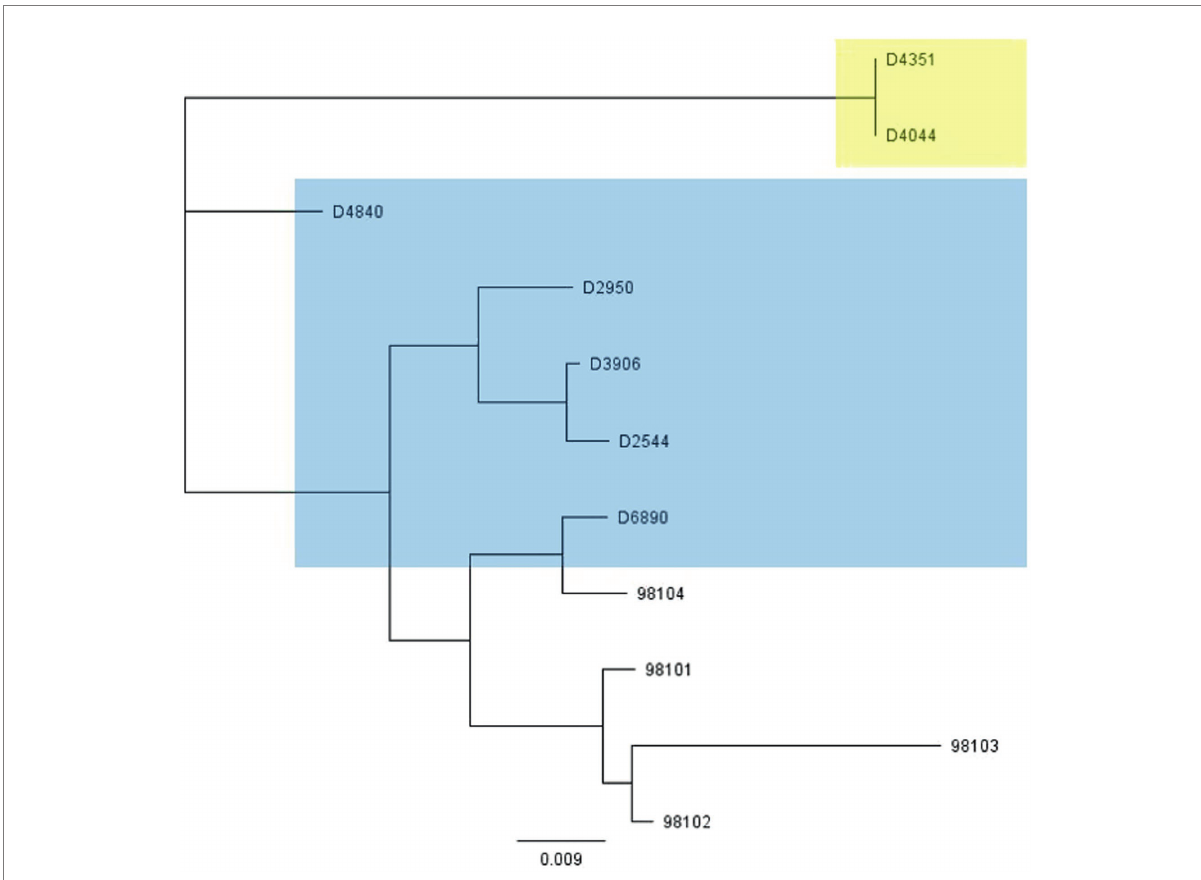
FIGURE 4 Phylogenetic tree showing nucleotide relatedness of the genes encoding the Bpp/RBPs of a subset of P335-group phages. Phages highlighted in blue infect strains encoding the 6073-like eps gene cluster. Phages highlighted in yellow infect strains encoding the 7127-like eps gene cluster. Phages that are not highlighted are public domain phages, and we have no data on their host eps gene content (Mahony et al.,